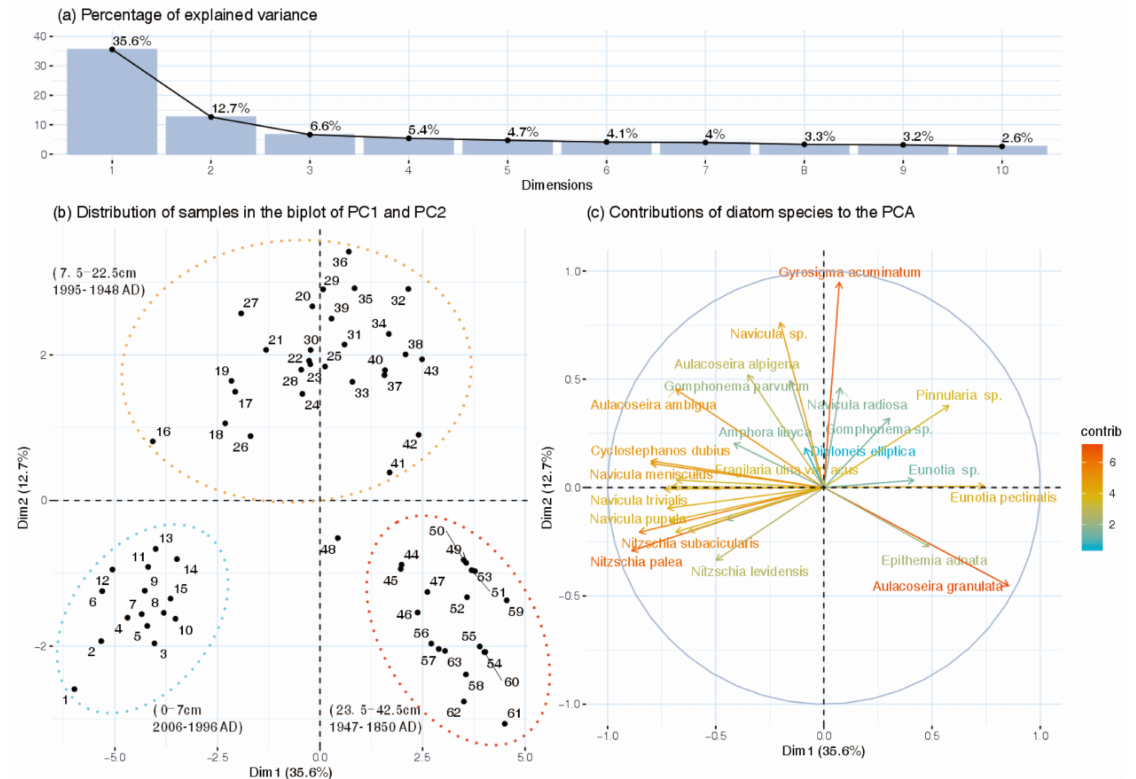
Figure 4. Explained variance of principal components, PC-scores along the first two axes of the PCAs, and contributions of diatom species. ( a ) percentage of explained variance; ( b ) distribution of sediment samples in the PCA biplot; ( c ) contributions of diatom species to the total